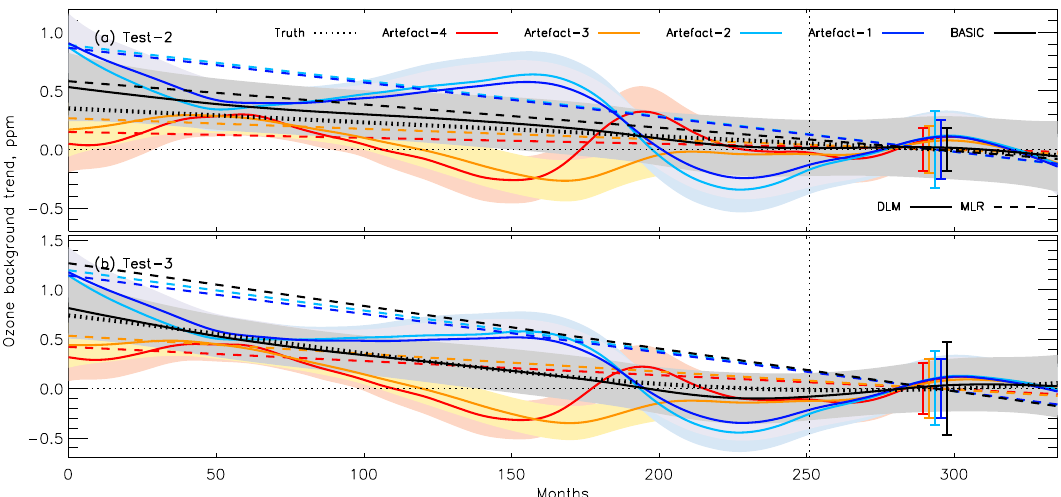
Figure A10. Similar to Fig. A9c: two additional tests cases where the only change is that the background trend in panel (a) is linear and in panel (b) non-linear, as shown with the thick, dotted black line.